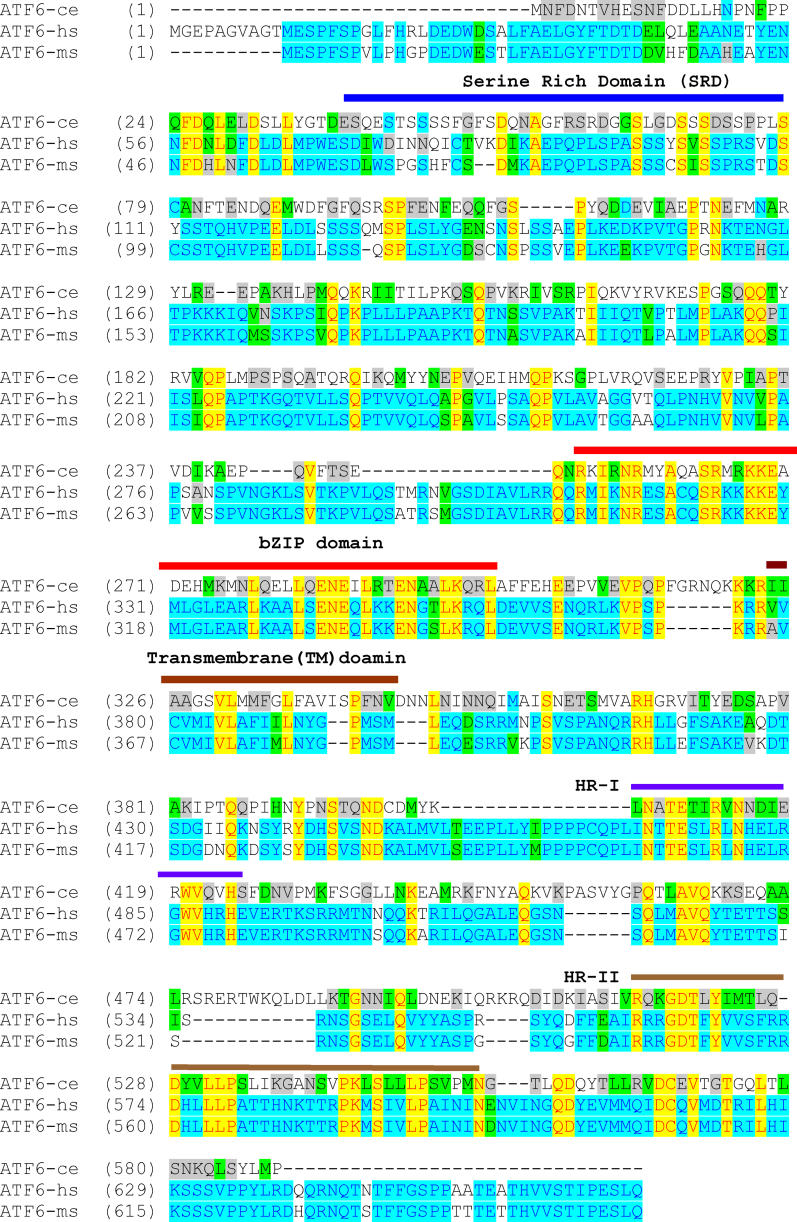
The Sequence Alignment of C. elegans, Human, and Murine ATF6 HomologsThe sequence alignment of C. elegans (ce), human (hs), and mouse (ms) shows five conserved regions in worm ATF-6 including a serine-rich domain, a bZIP domain, a transmembrane domain, and two C-terminal homology regions (HR-I and HR-II). Blue indicates residues that are conservative across species, green indicates blocks of similar residues, yellow indicates identical residues, and grey indicates weak similarity.